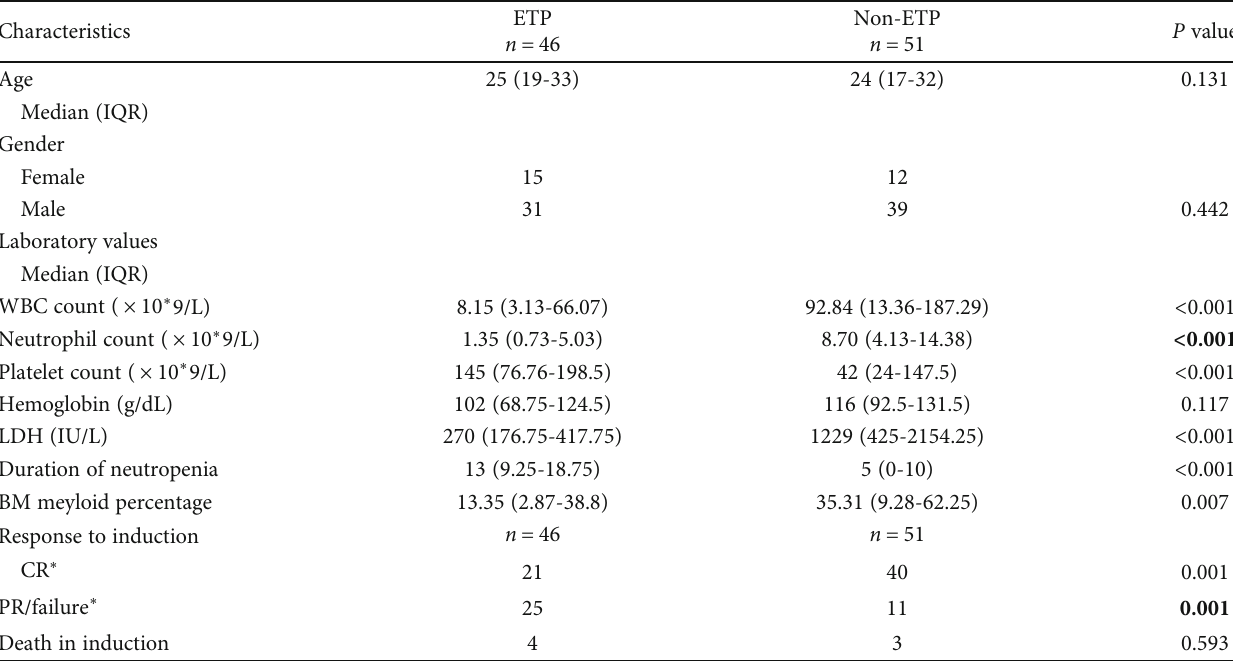
Figure 1: Flow diagram of induction-related infections. Forty-six patients in the ETP cohort experienced 69 episodes of induction-related infection, while 51 cases in non-ETP cohort had 23 episodes of infections in 24 days of induction phase. ETP: early T-cell progenitor ALL; non-ETP: non-early T-cell progenitor ALL; FOU: fever of uncertain origin; CDI: clinically documented infection; MDI: microbiologically documented infection. Table 1: Clinical characteristics of T-ALL adult